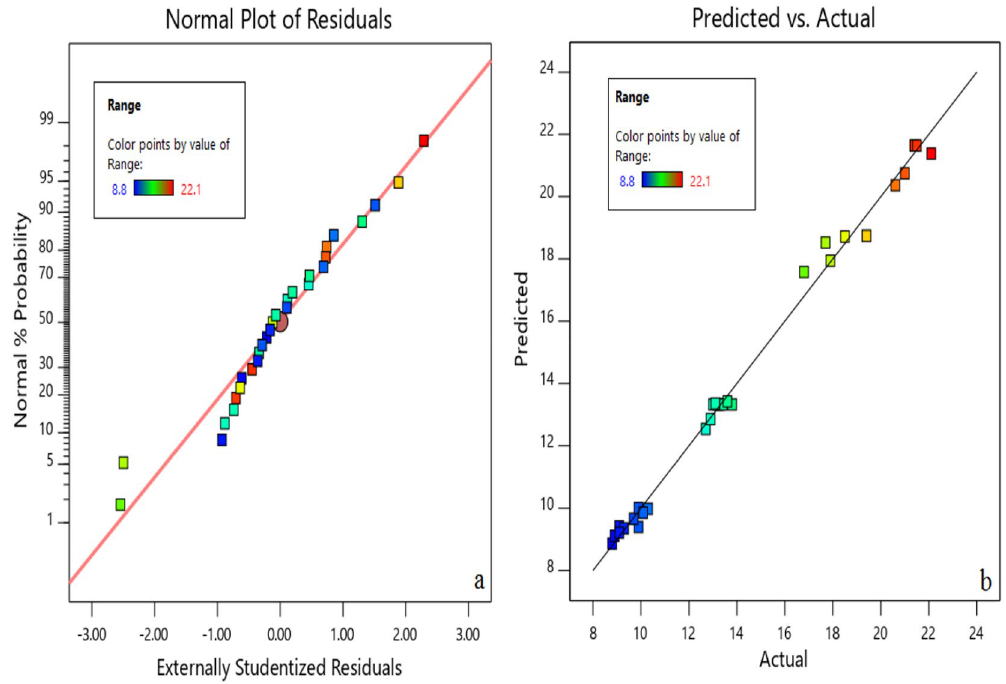
Figure 7. ( a ) Normal plot of residuals for CFCT cooling range ( b ) the acquired experimental values compared to the predicted cooling range values for TiO 2 nanofluid.